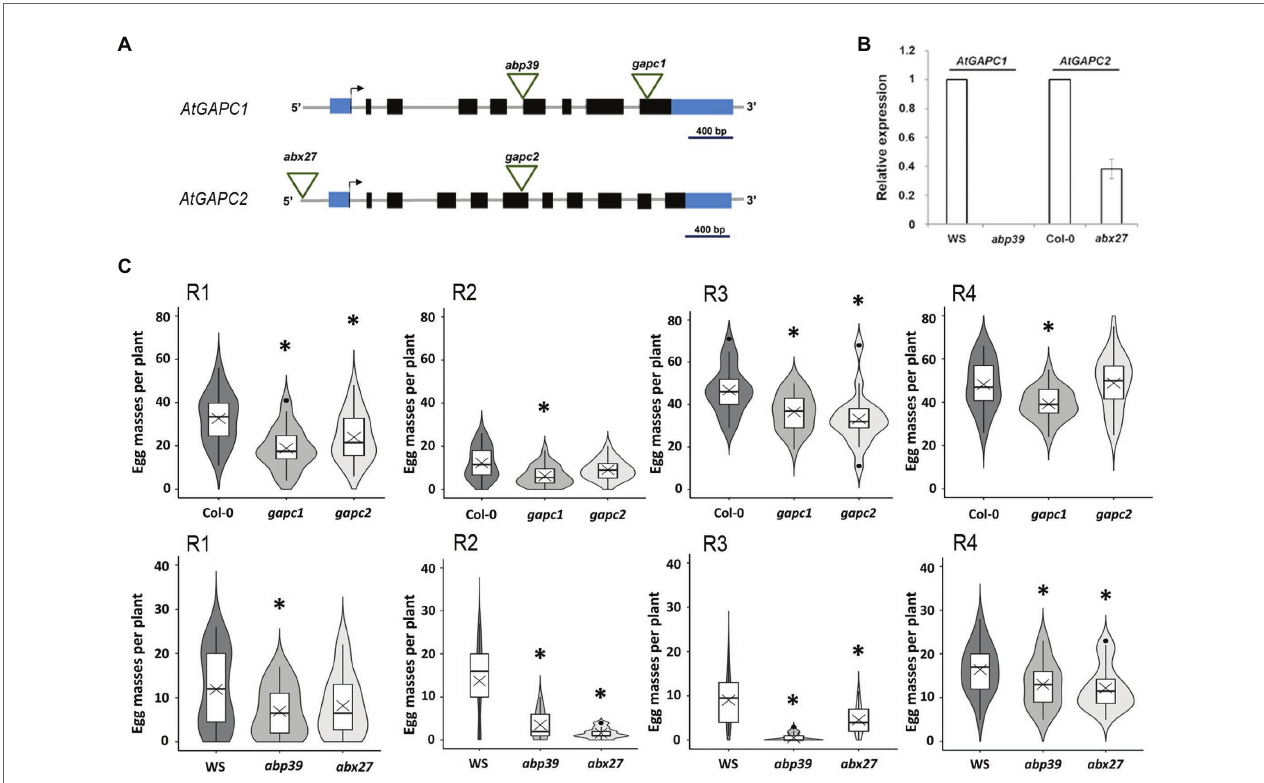
FIGURE 4 | AtGAPC1 and AtGAPC2 are involved in Arabidopsis susceptibility to M. incognita . (A) Schematic illustration of the genomic organization of AtGAPC1 and AtGAPC2 and T-DNA insertion sites. Black boxes represent exons, gray lines correspond to introns, blue boxes represent untranslated sequences and the arrows represent START codons. (B) RT-qPCR analysis of AtGAPC1 and AtGAPC2 expression in abp39 and abx27 mutants. Data were normalized against OXA1 and UBP22 constitutive genes. (C) Results of four independent nematode infection assays, performed on Arabidopsis mutants AtGAPC1 ( gapc1 and abp39 ) and AtGAPC2 ( gapc2 and abx27 ), relative to wild-type plants (Col-0 and WS). Number of egg masses ( y -axis), at 6 weeks post infection, in independent nematode infection assays, is shown as violin-plot diagrams. Box indicates interquartile range (25–75th percentile). The horizontal bar in the box indicates the median of the reported values. The crosses show the mean value. Whiskers mark the lowest and highest values within 1.5 times the interquartile range, and black dots indicate outliers. The box plot is included in a kernel density plot (shade of grays) showing the entire distribution of the data. R1–R4 indicate independent replicates. n = 17–25 plants per line. Asterisks indicate a significant difference between the wild-type and the mutant lines, as shown by Student’s t test ( p <